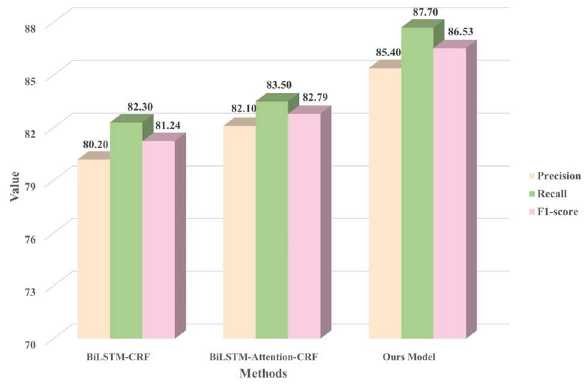
Figure 6. Experimental results for the proposed model and the baseline model.